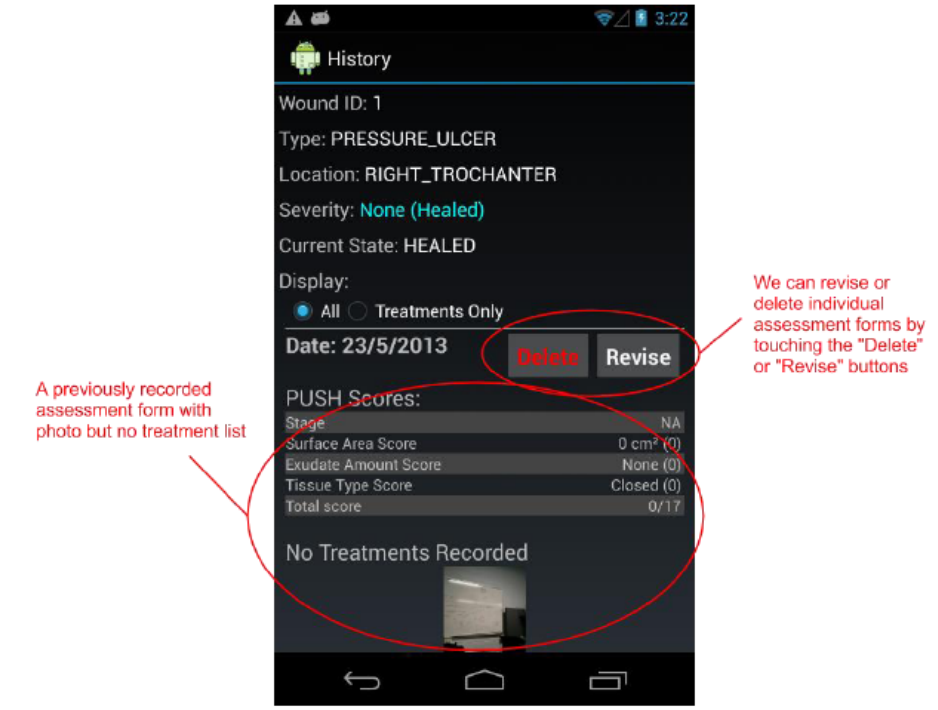
Figure 7. The Wound History screen shows us every assessment recorded (including treatments list and photo) for a selected wound. We may also delete and revise individual assessments from this screen.